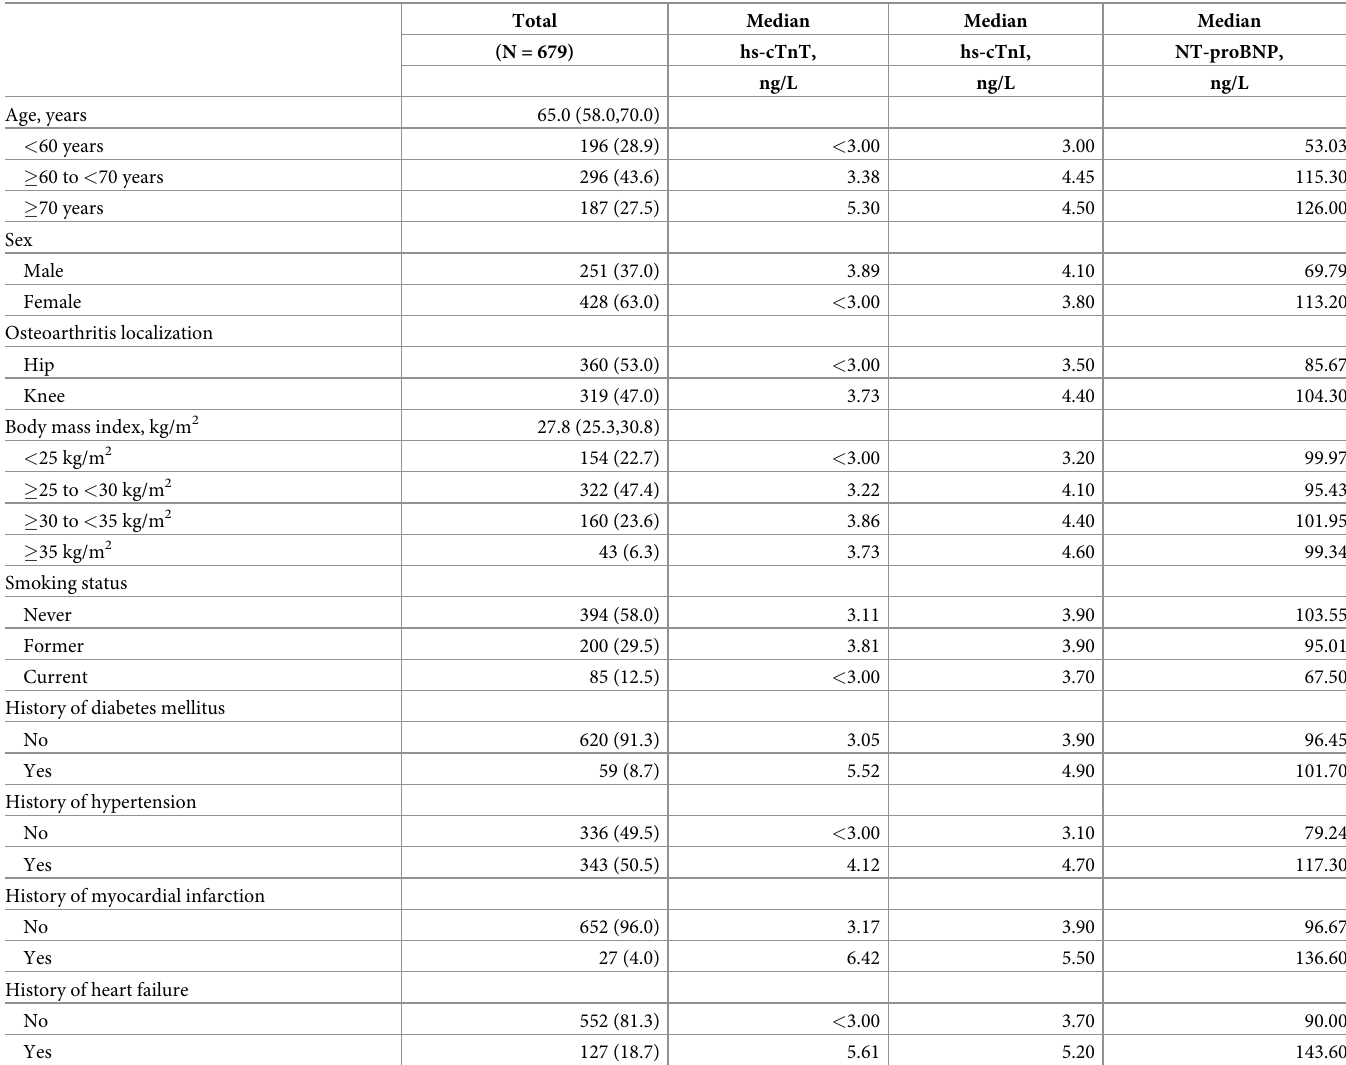
Table 1. Baseline characteristics and median biomarker